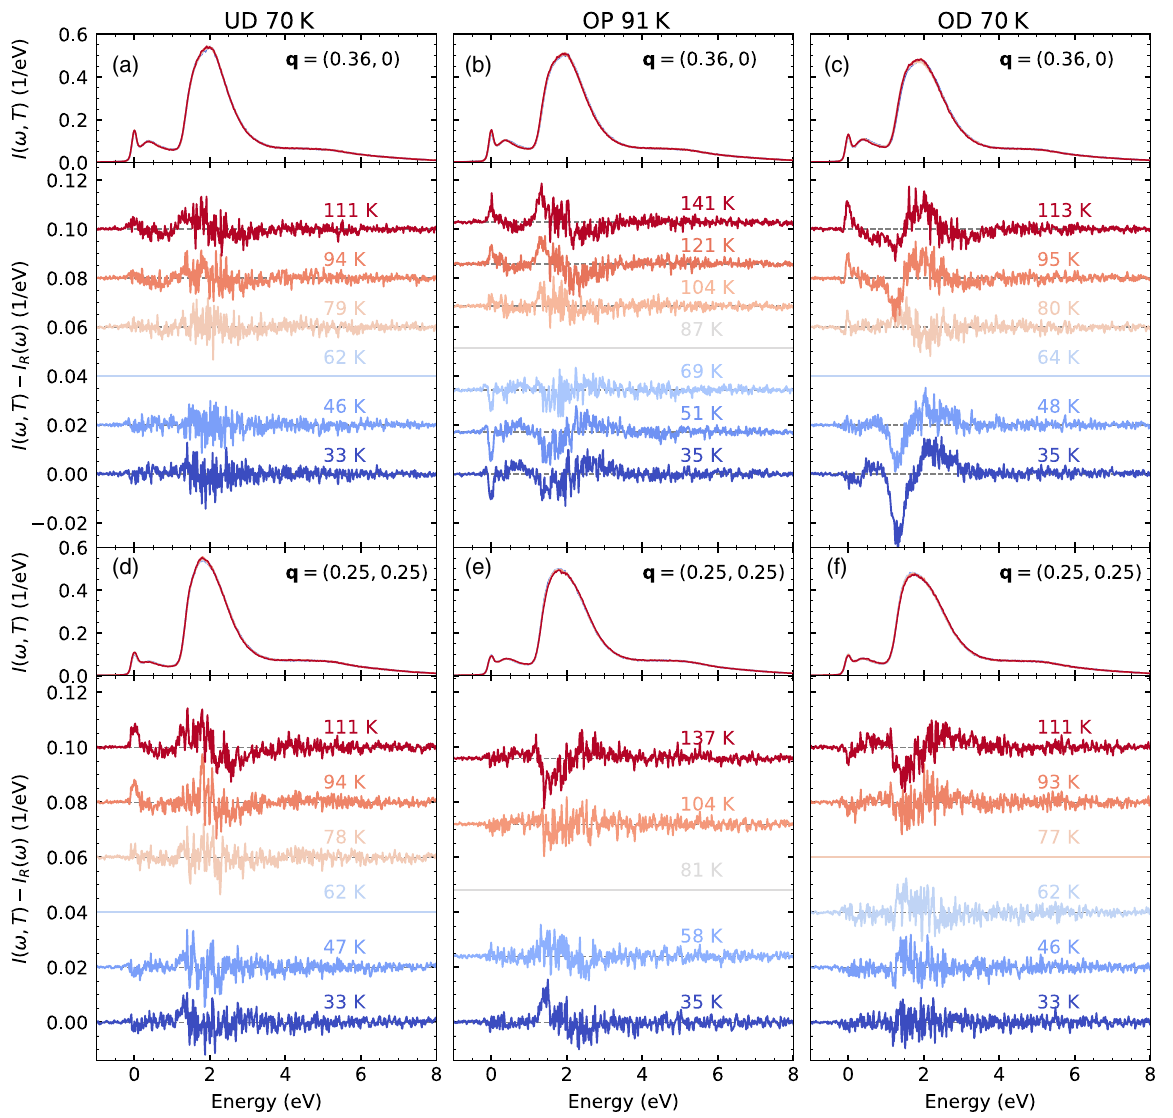
FIG. 2. Top panels: normalized RIXS spectra. The spectra for different temperatures overlap except near the maximum of the dd peak. Bottom panels: normalized RIXS spectra for the same temperatures as the top panels from which the spectra at T ¼ 70 K). (b),(e) Optimally doped Bi-2212 ( T (a),(c) Underdoped Bi-2212 ( T c (a) – (c) Momentum value (0.36, 0). (d) – (f) Momentum value (0.25,